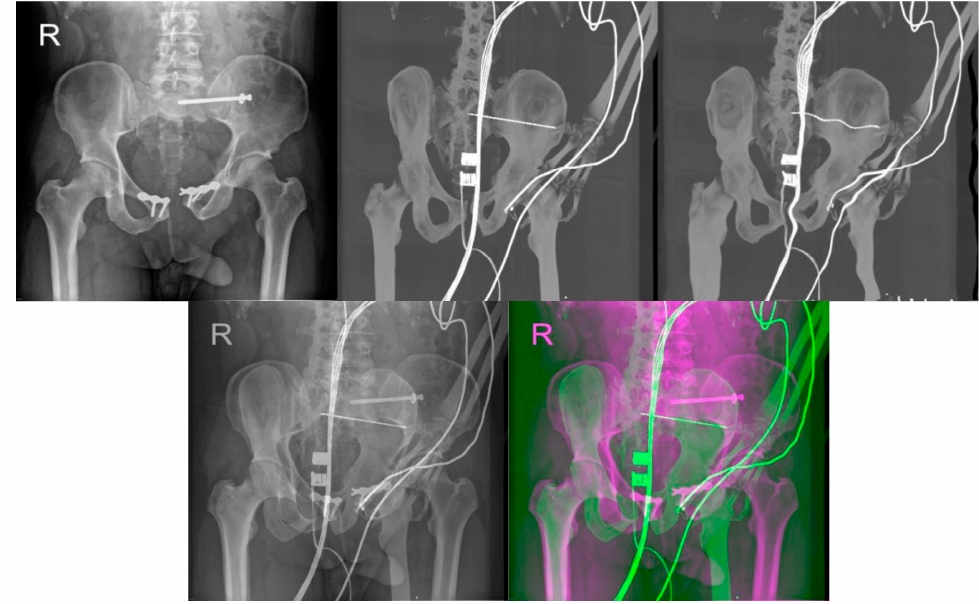
Figure 9. The output of image registration for Patient 2. Left to Right : Reference X-ray image, input DRR projection, output DRR projection, alpha blending composite image and RGB composite image.